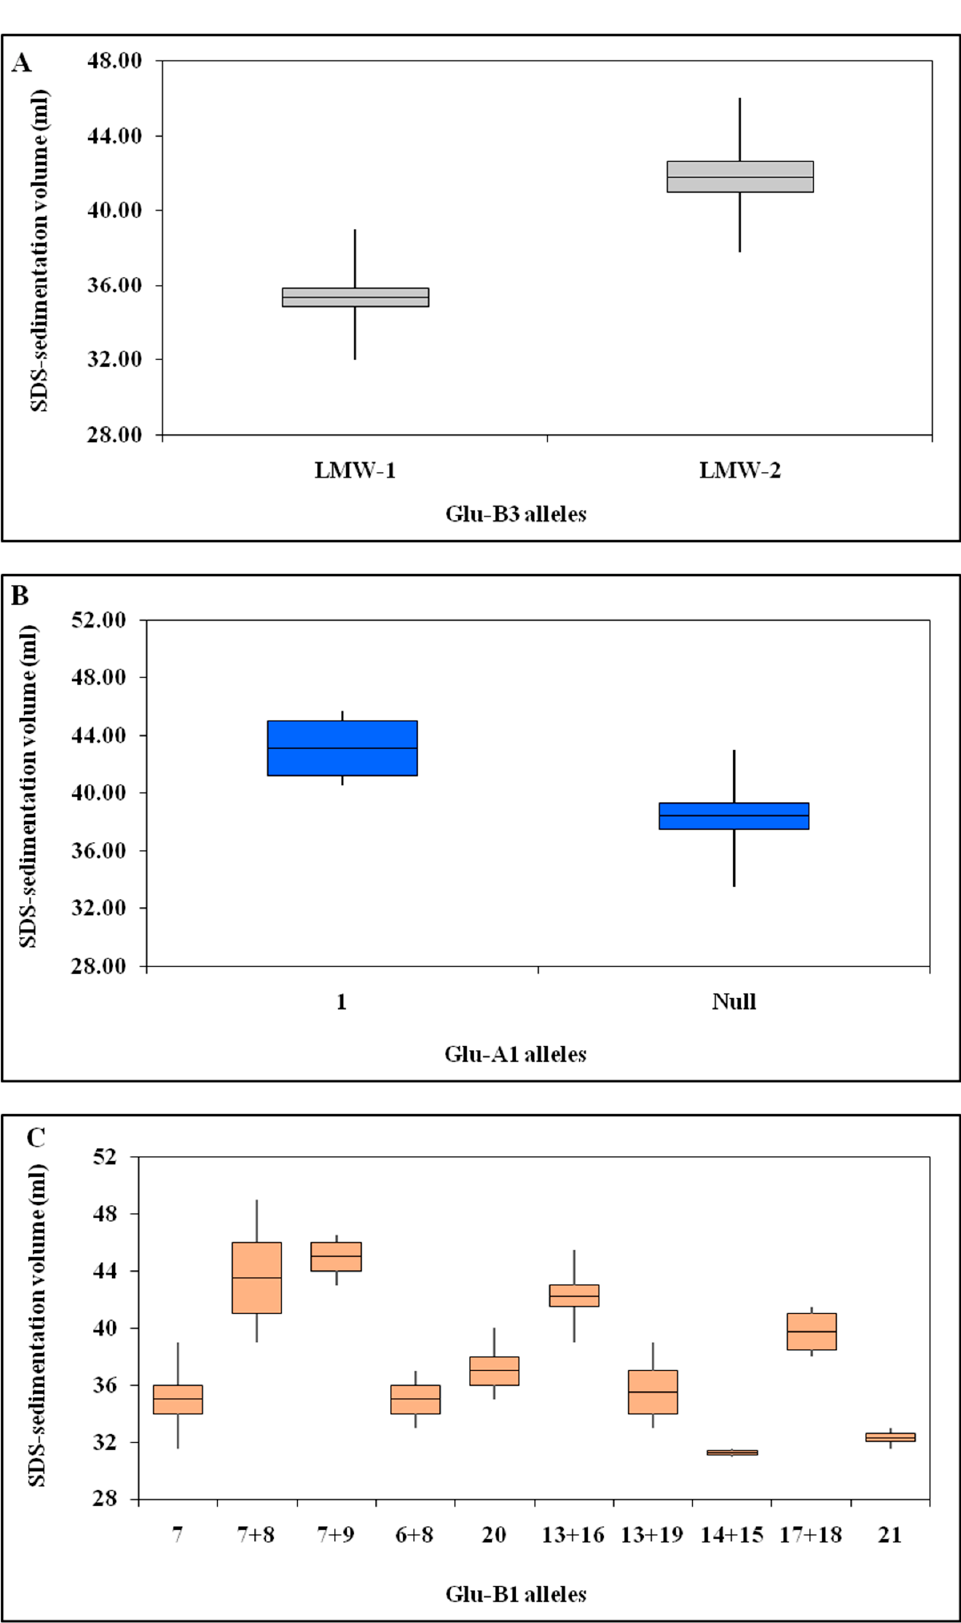
Figure 2. Effects of allelic variation on gluten strength at the Glu-B3 locus( A ) Glu-A1 locus ( B ), and Glu-B1 locus ( C